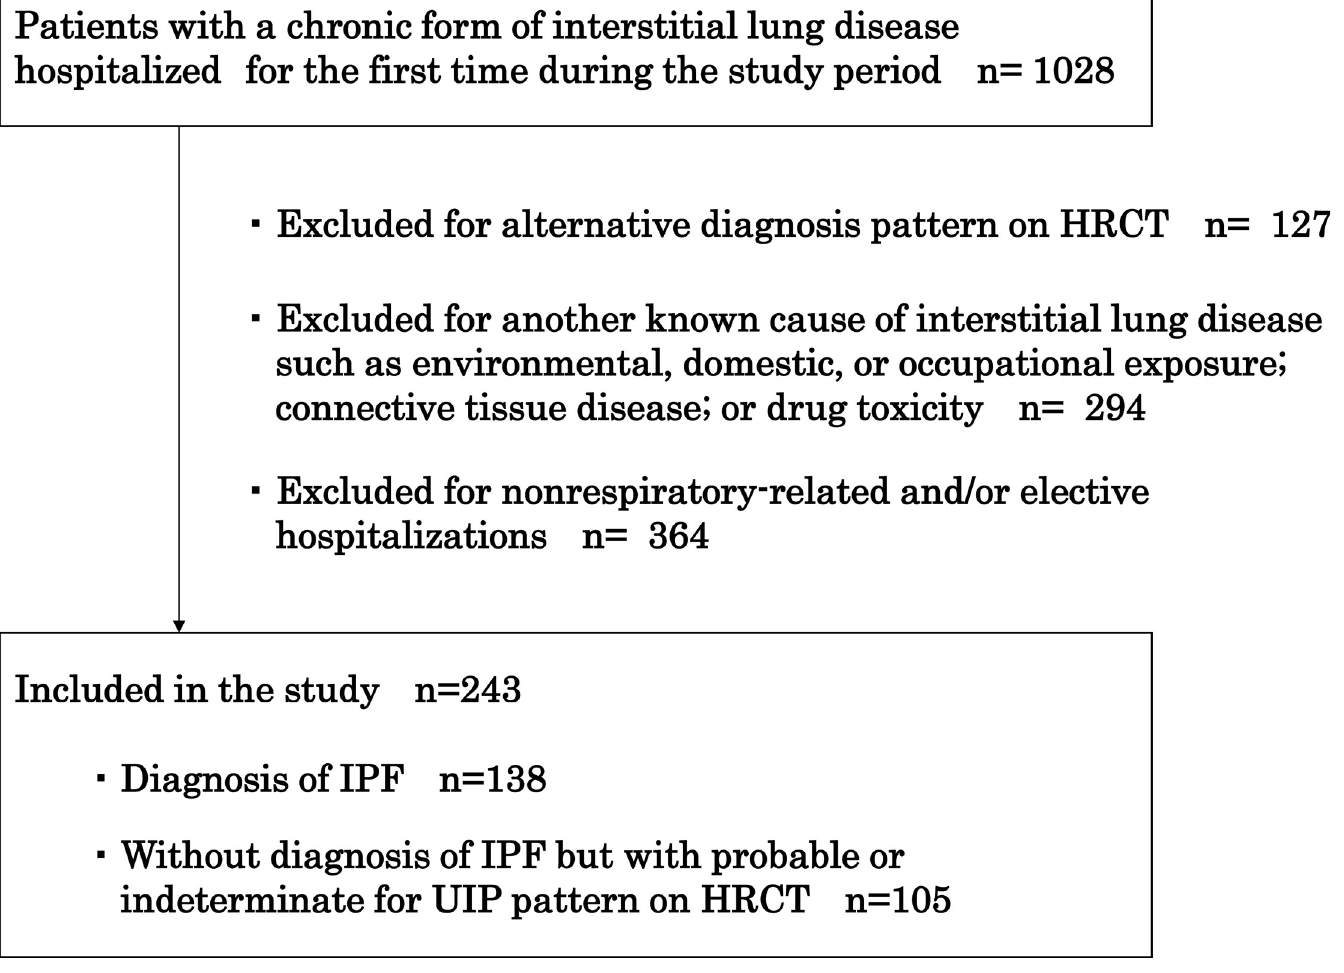
Fig 1. Flow chart of inclusion and exclusion criteria. HRCT, high-resolution computed tomography; IPF, idiopathic pulmonary fibrosis; UIP, usual interstitial pneumonia.